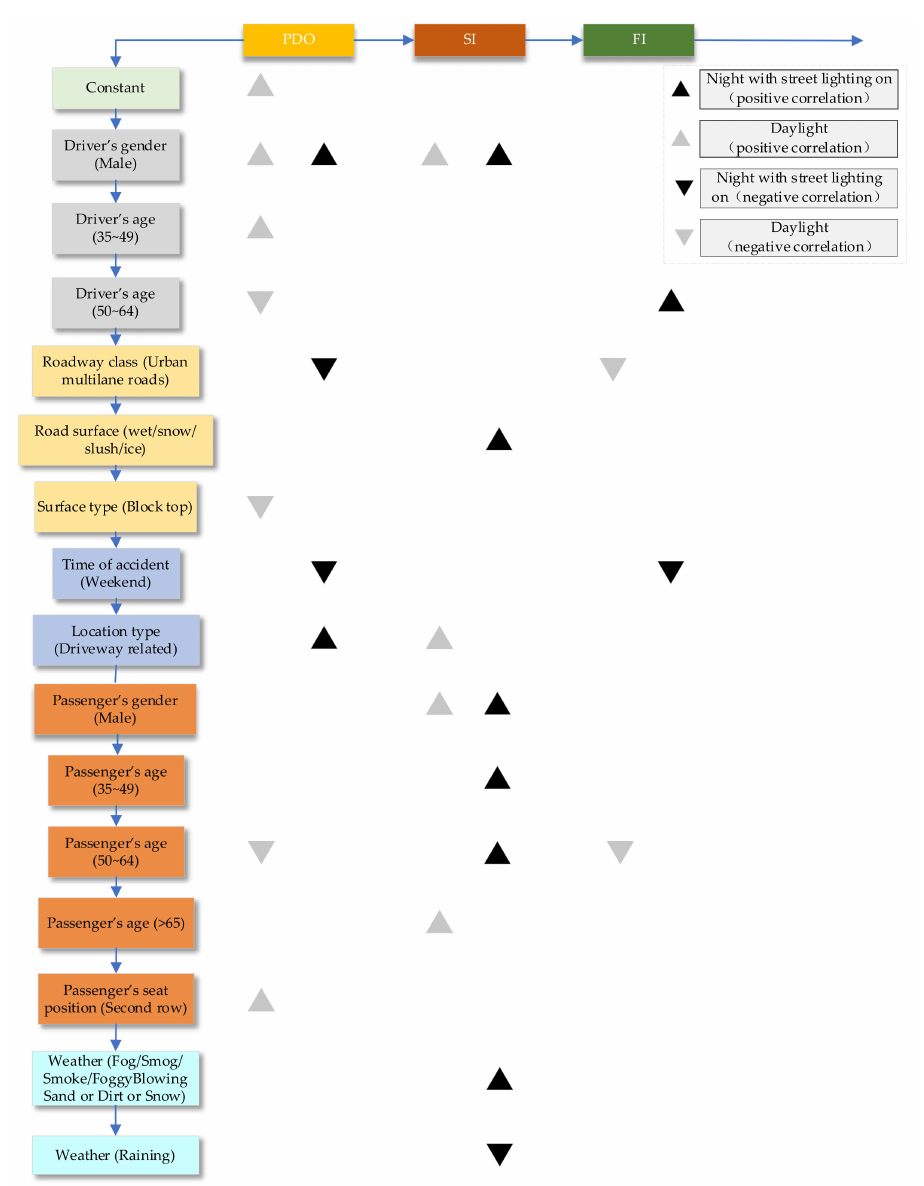
Figure 2. The trend impacted by significant factors of accidents in 2018. Cloudy, rainy, snowy, windy, and foggy weather would increase the probability of PDO accidents and SI accidents compared with sunny weather under different lighting conditions, which demonstrated the temporal instability of parameters. The estimation results in 2016 and 2017 showed that when the accidents occurred on weekends, it could be more severe than on a weekday. The difference between the performance of location types also demonstrated temporal instability among three